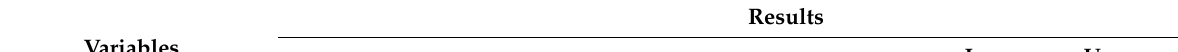
Table 2. Pharmacists’ opinions on interprofessional